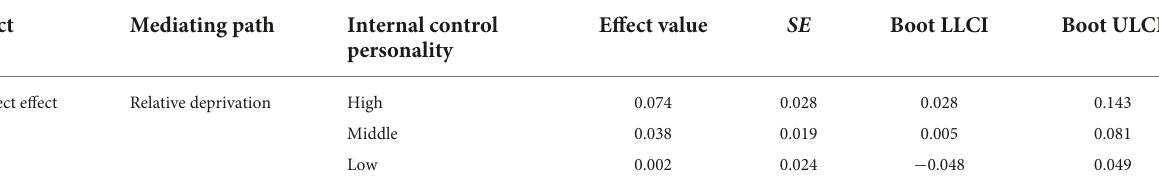
TABLE 5 Test of moderated mediating